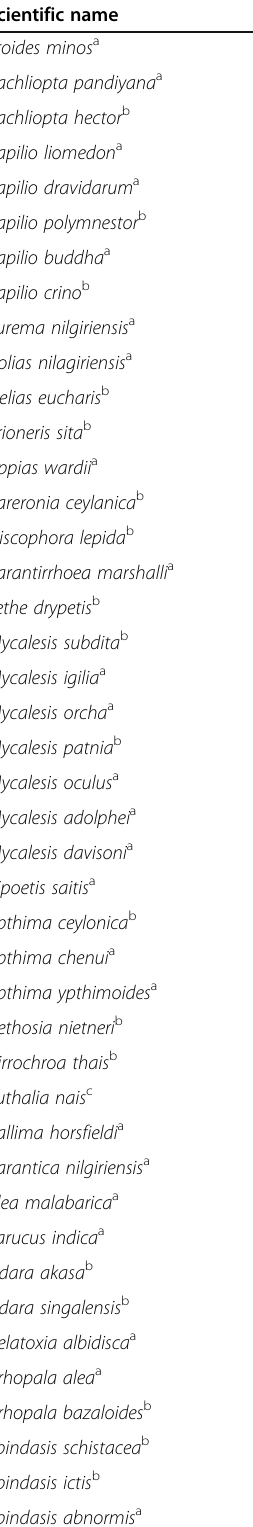
Table 2 Species recorded as endemic to the Western Ghats, Sri Lanka and peninsular